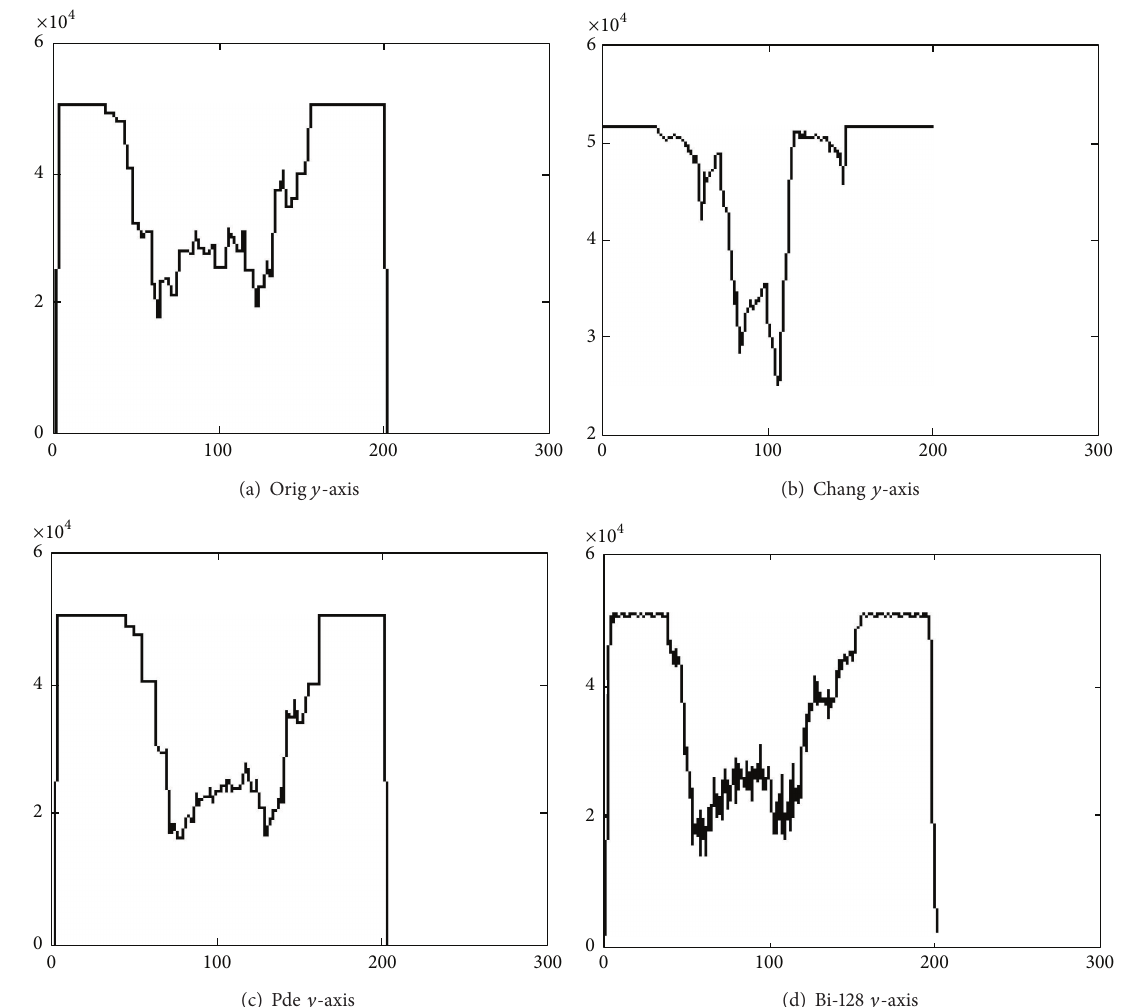
Figure 10: Comparison in Experiment 1: projection of images to the 𝑦 -axis: (a) original image, (b) distorted image by harmonic transformation, (c) restored image by IEWC, and (d) restored image by the piecewise bilinear method.